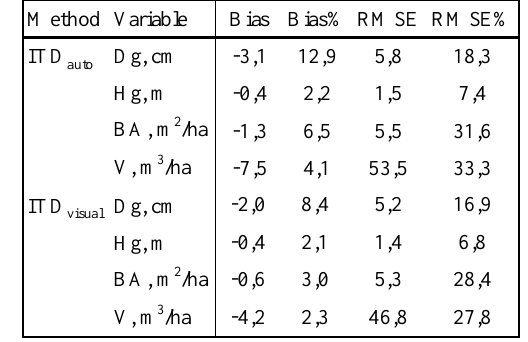
Table 3. Accuracy of ITD auto and ITD visual at plot level. Prediction accuracy of volume, by main tree species for Scots pine, Norway spruce and deciduous trees (mainly birch), with ITD auto were (RMSE%) of 29.8%, 38.0% and 37.2%, respectively. Accuracies (Table 4) increased with ITD visual - method (e.g. volume accuracy for spruce was 23.0%). Larger bias% for Scots pine and desiduous trees (birch) was mainly caused by comission errors.